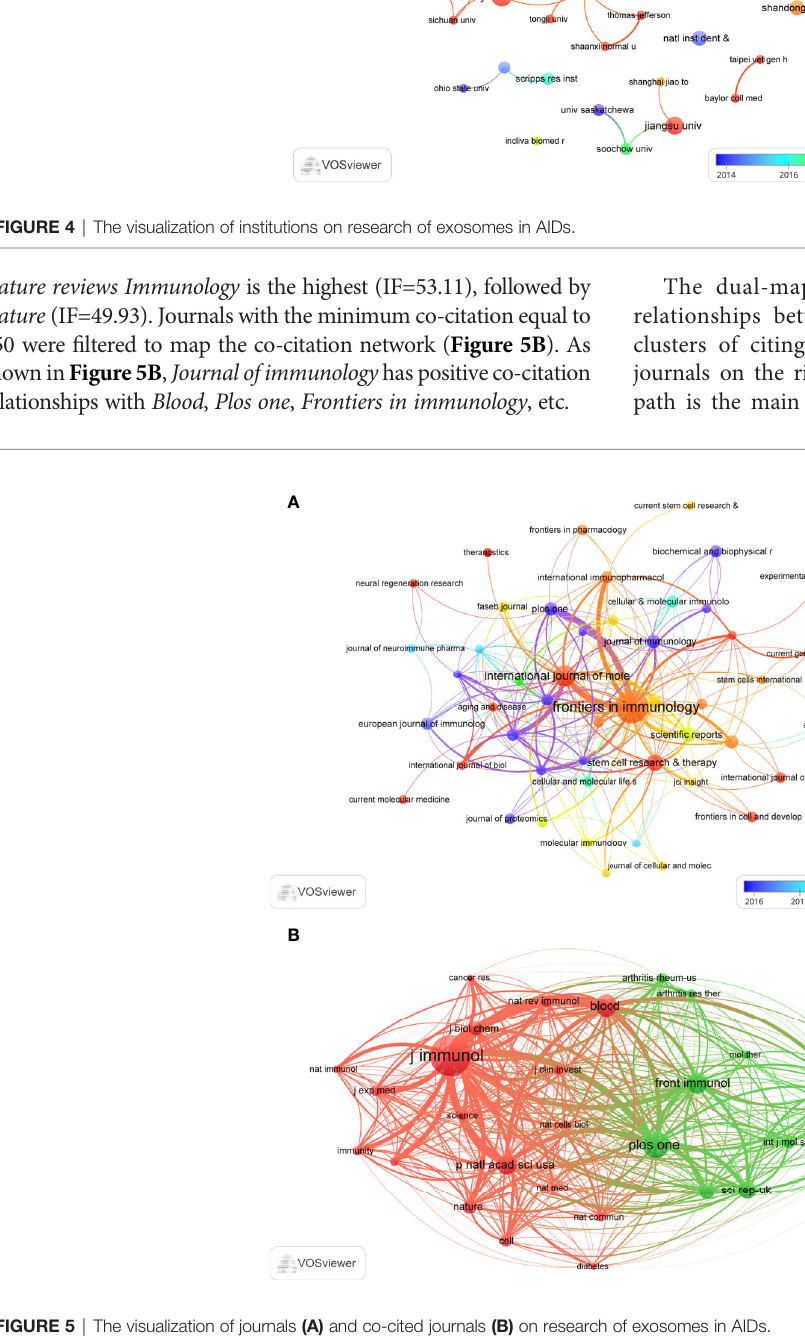
FIGURE 5 | The visualization of journals (A) and co-cited journals (B) on research of exosomes in